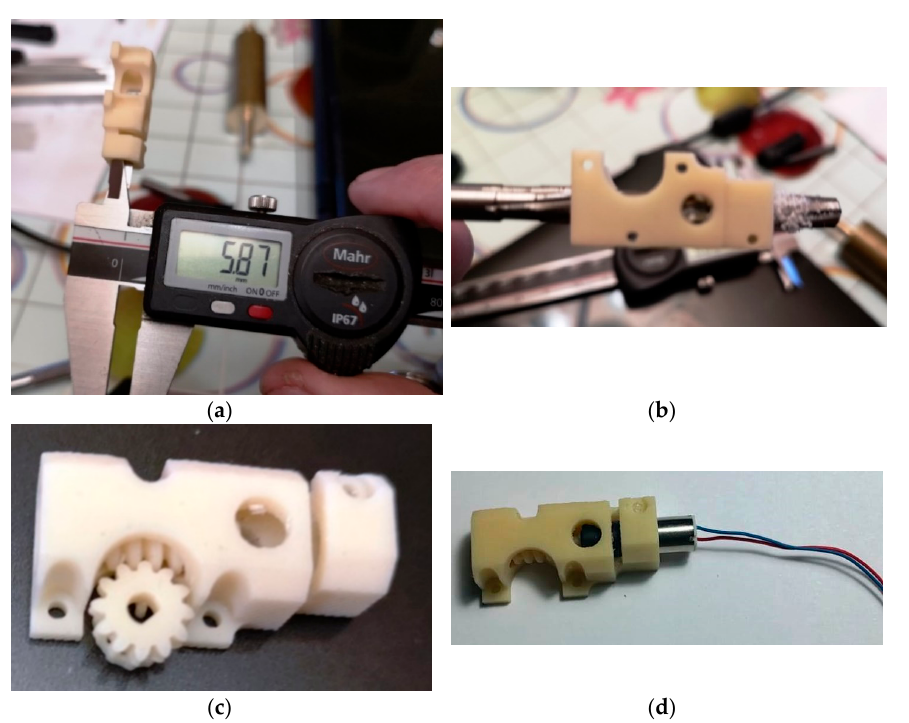
Figure 19. Checking the geometric precision of the 3SP printed parts. ( a ) Whole dimension in a section: 5.87, instead of 6 mm, ( b ) manual reamer to adjust the whole, ( c ) the gear–worm gear needed to be further adjusted for correct motion transmission, ( d ) incorrect assembly of the micro-motor and the case